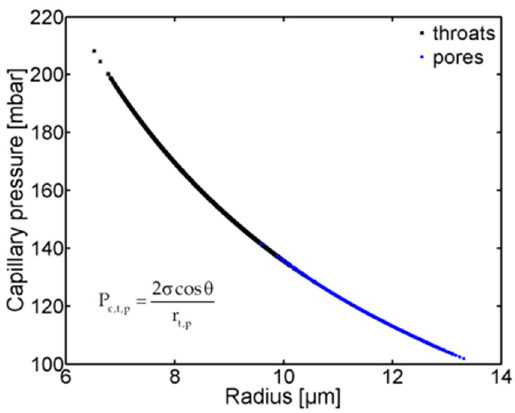
Figure 6. Capillary pressure variation in the studied range of pore sizes (standard deviation of 0.5 µ m,